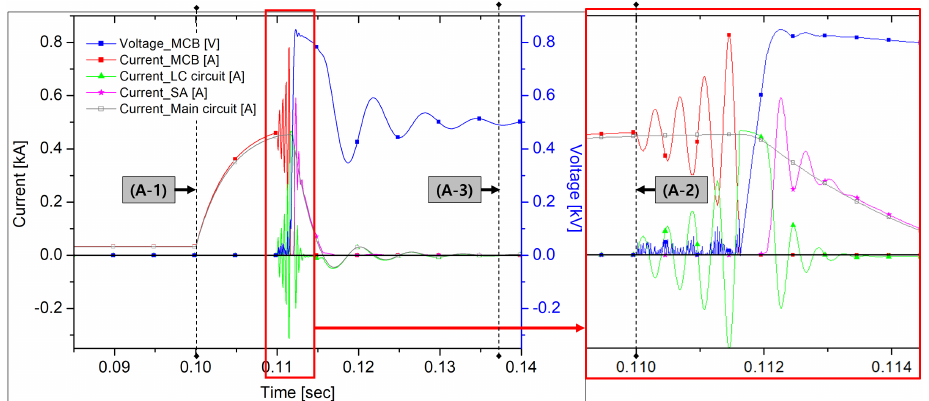
Figure 2. Graphs of the operating characteristic of the DC circuit breaker to which divergence oscillation method is applied in the simulation.